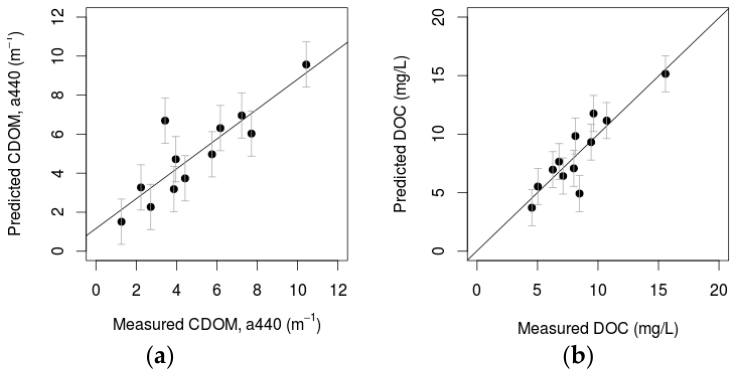
Remote Sens. 2016 , 8 , 803 Figure 6. ( a ) Relationship between predicted CDOM at 440 nm (m − 1 ) and measured CDOM at 440 nm (m − 1 ) (CDOM predicted = 1.15 + 0.76 × CDOM measured , R 2 = 0.76, p -value < 0.001, RMSE = 1.2). ( b ) Relationship between predicted DOC in mg/L and measured DOC in mg/L (DOC predicted = 0.02 + 0.99 × DOC measured , R 2 = 0.79, p -value < 0.001, RMSE = 1.4).